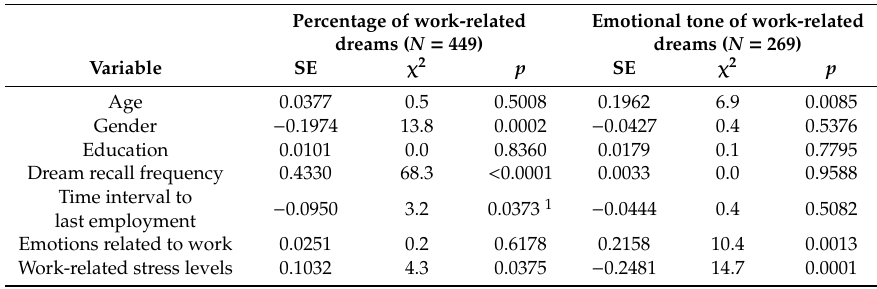
Table 6. Ordinal regression analysis for the categorized (ordinal) percentage of work-related dreams and the emotional tone of work-related dreams (only for individuals currently not